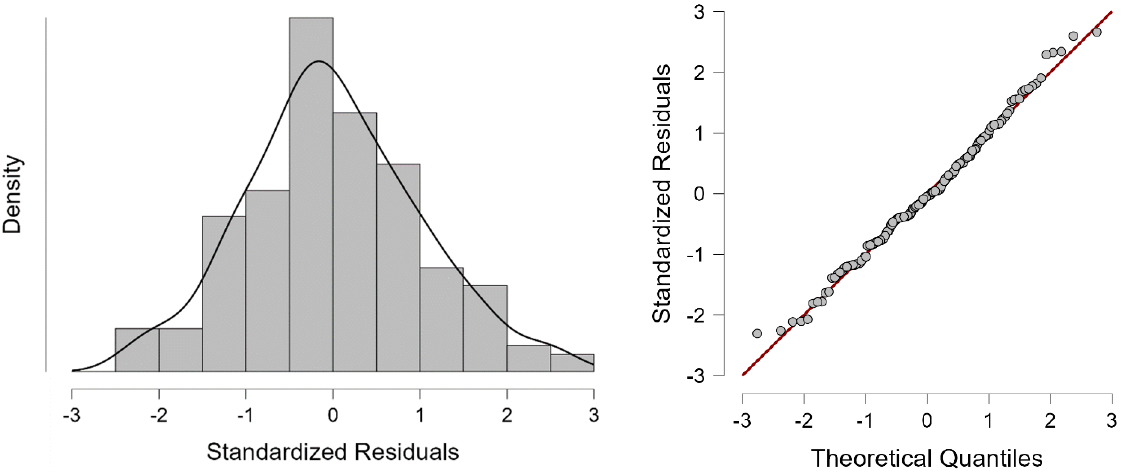
Figure 4. Histogram and normal Q − Q plot of standardized residuals .